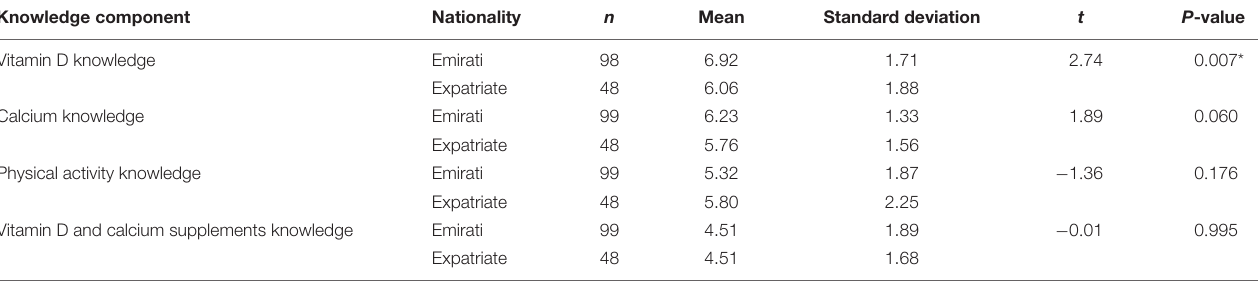
TABLE 4 | Comparison of overall score of knowledge among Emirati and tourist sample.